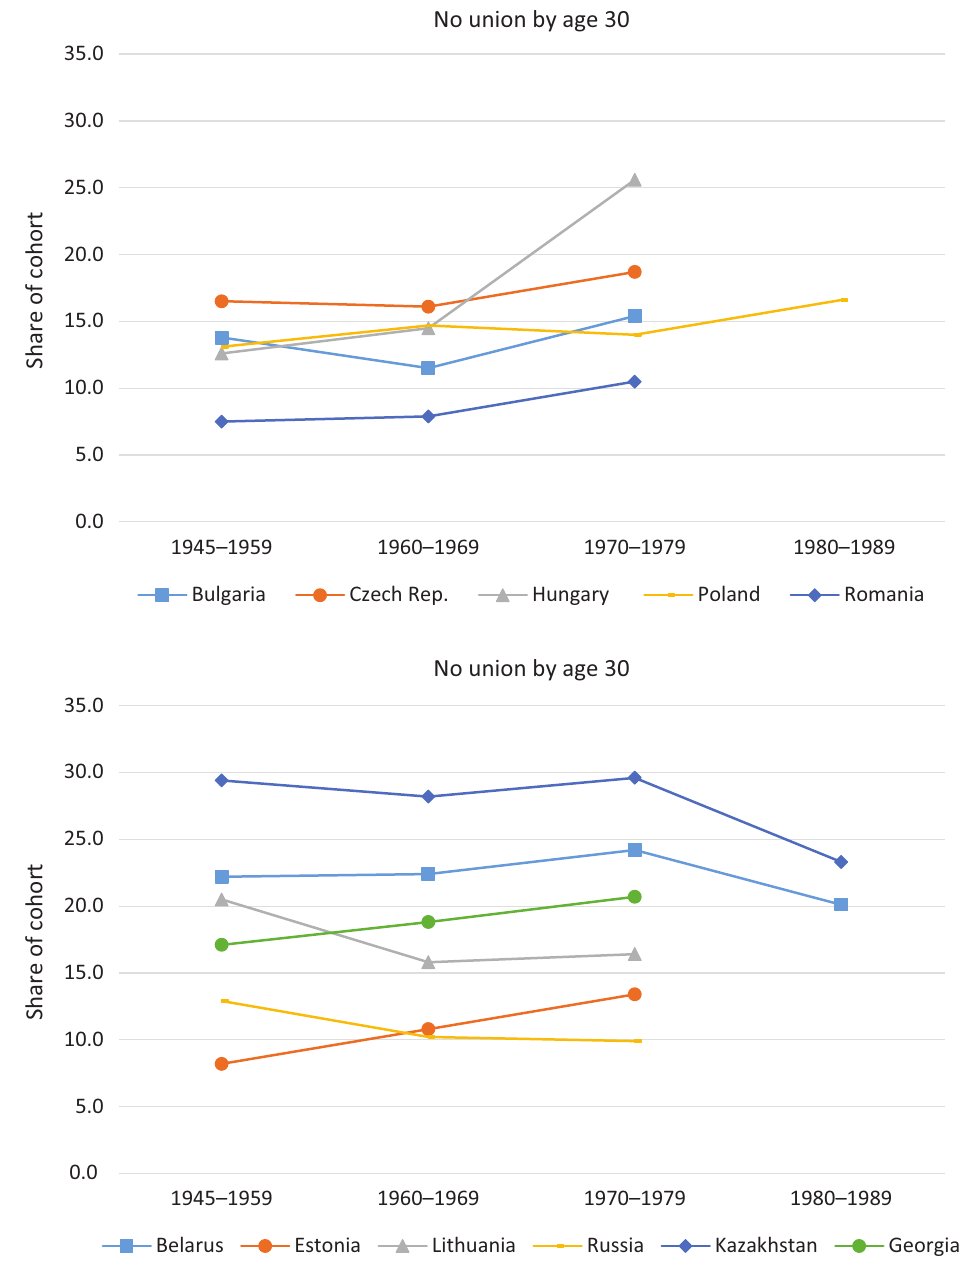
Figure 2. Share of women that did not enter a co‐residential union by the age of 30 by country and birth